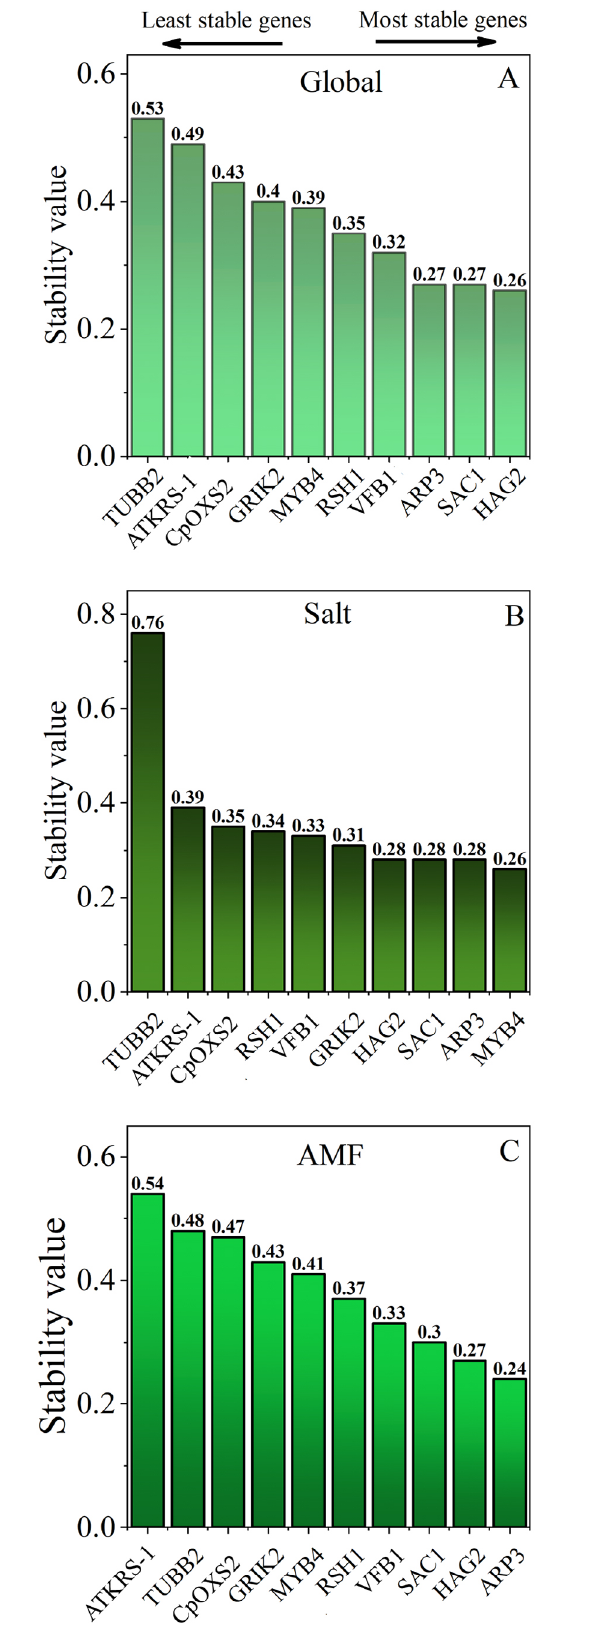
Figure 3 - NormFinder stability analysis of 10 candidate reference genes (CRGs) for analyzed assays. Lower values indicate a more stable expression. A- Global (Salt + arbuscular mycorrhizal fungi, AMF); B- Salt; C- AMF